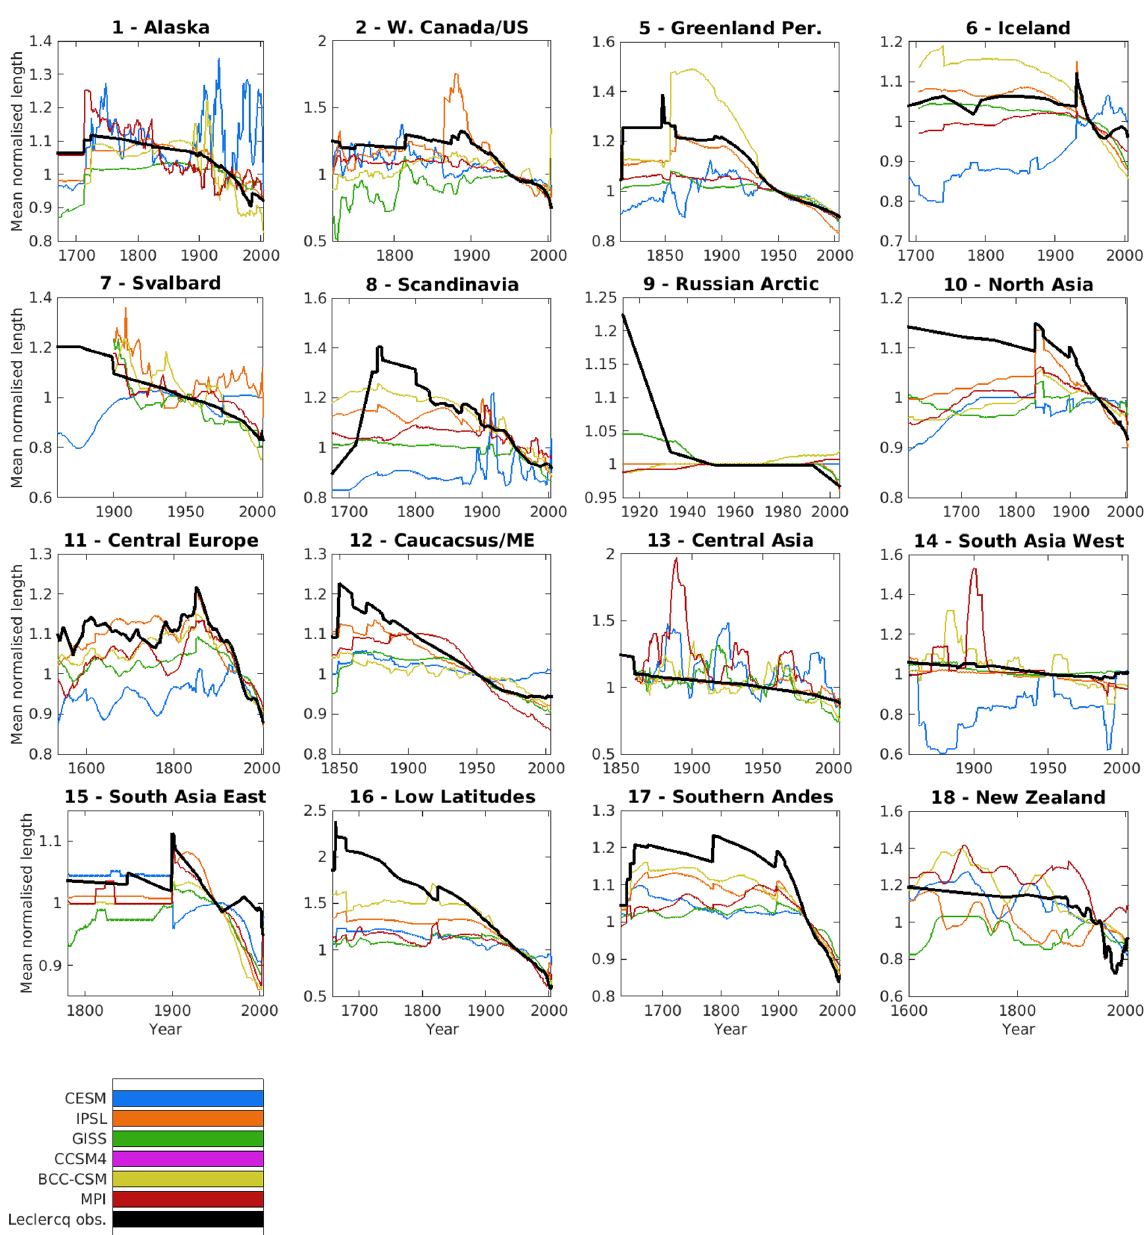
Figure 4. Length changes for the period of observational record represented by the Leclercq et al. (2014) glaciers in each region across 16 RGI regions, modelled by OGGM using six separate GCM products (CESM, IPSL, GISS, BCC-CSM, CCSM4, and MPI). Unlike in Fig. 3, the modelled mean in each year includes only the glaciers for which Leclercq data covers that year, resulting in some of data artefacts that come from glaciers entering or leaving the set that contributes to the regional mean being reflected in both the observed and the modelled